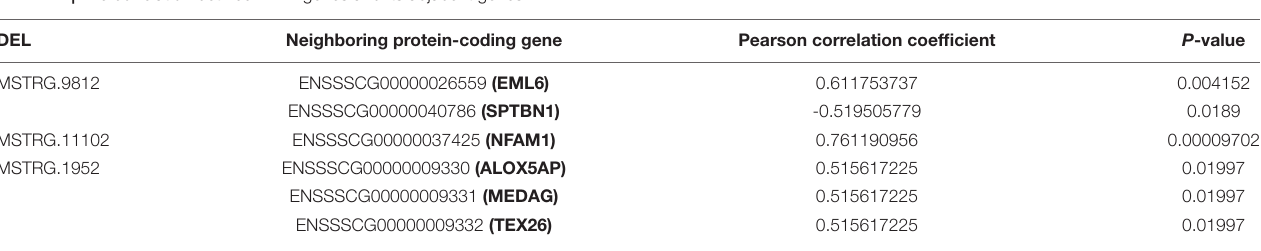
TABLE 2 | The correlation between DEL genes and its adjacent genes. DEL Neighboring protein-coding gene Pearson correlation coefficient P